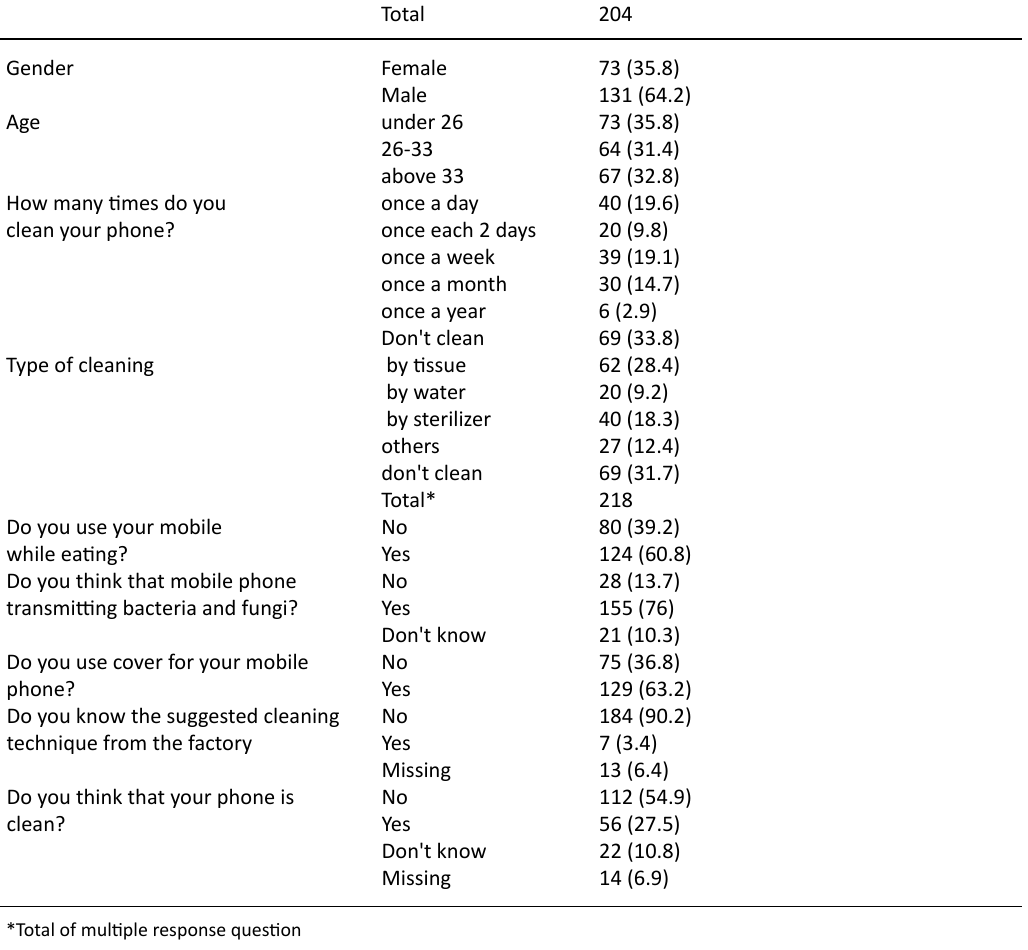
Table 1. Behavior and practice of mobile phone hygiene in total participants